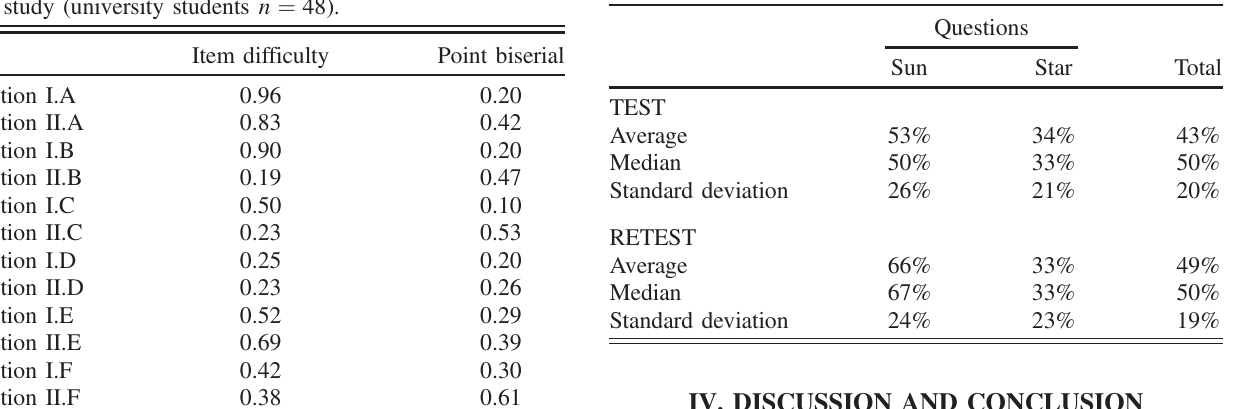
TABLE VI. Test results of secondary school students ( n ¼ 33